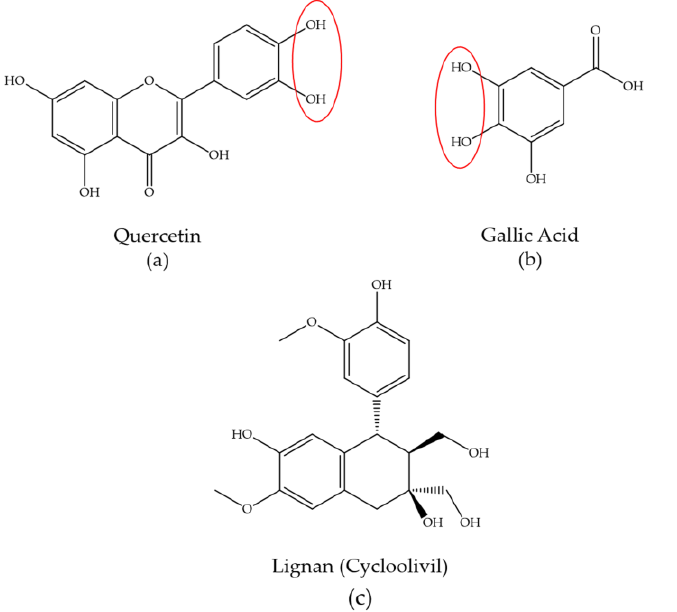
Figure 3. Structure of polyphenolic compounds contained in plant extracts. ( a , b ) Polyphenols with ortho-substituted hydroxyl. ( c ) Polyphenol without ortho-substituted hydroxyl. Note: red circle is ortho substituted hydroxyl group as preferred complexation sites.